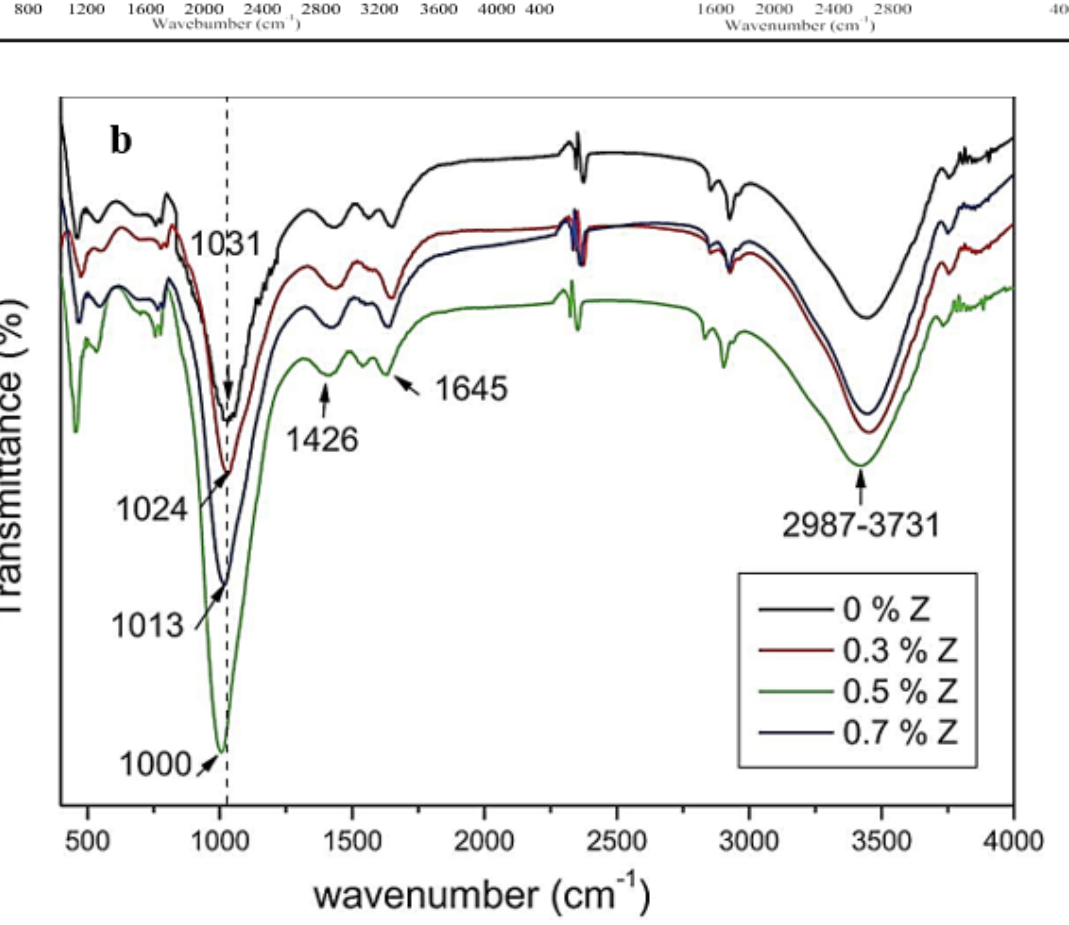
Figure 12. ( a ) The FTIR spectra for NS (reproduced Copyright 2022, with permission from Elsevier [33]); ( b ) shows the FTIR spectra for nano-ZnO (reproduced from [95].